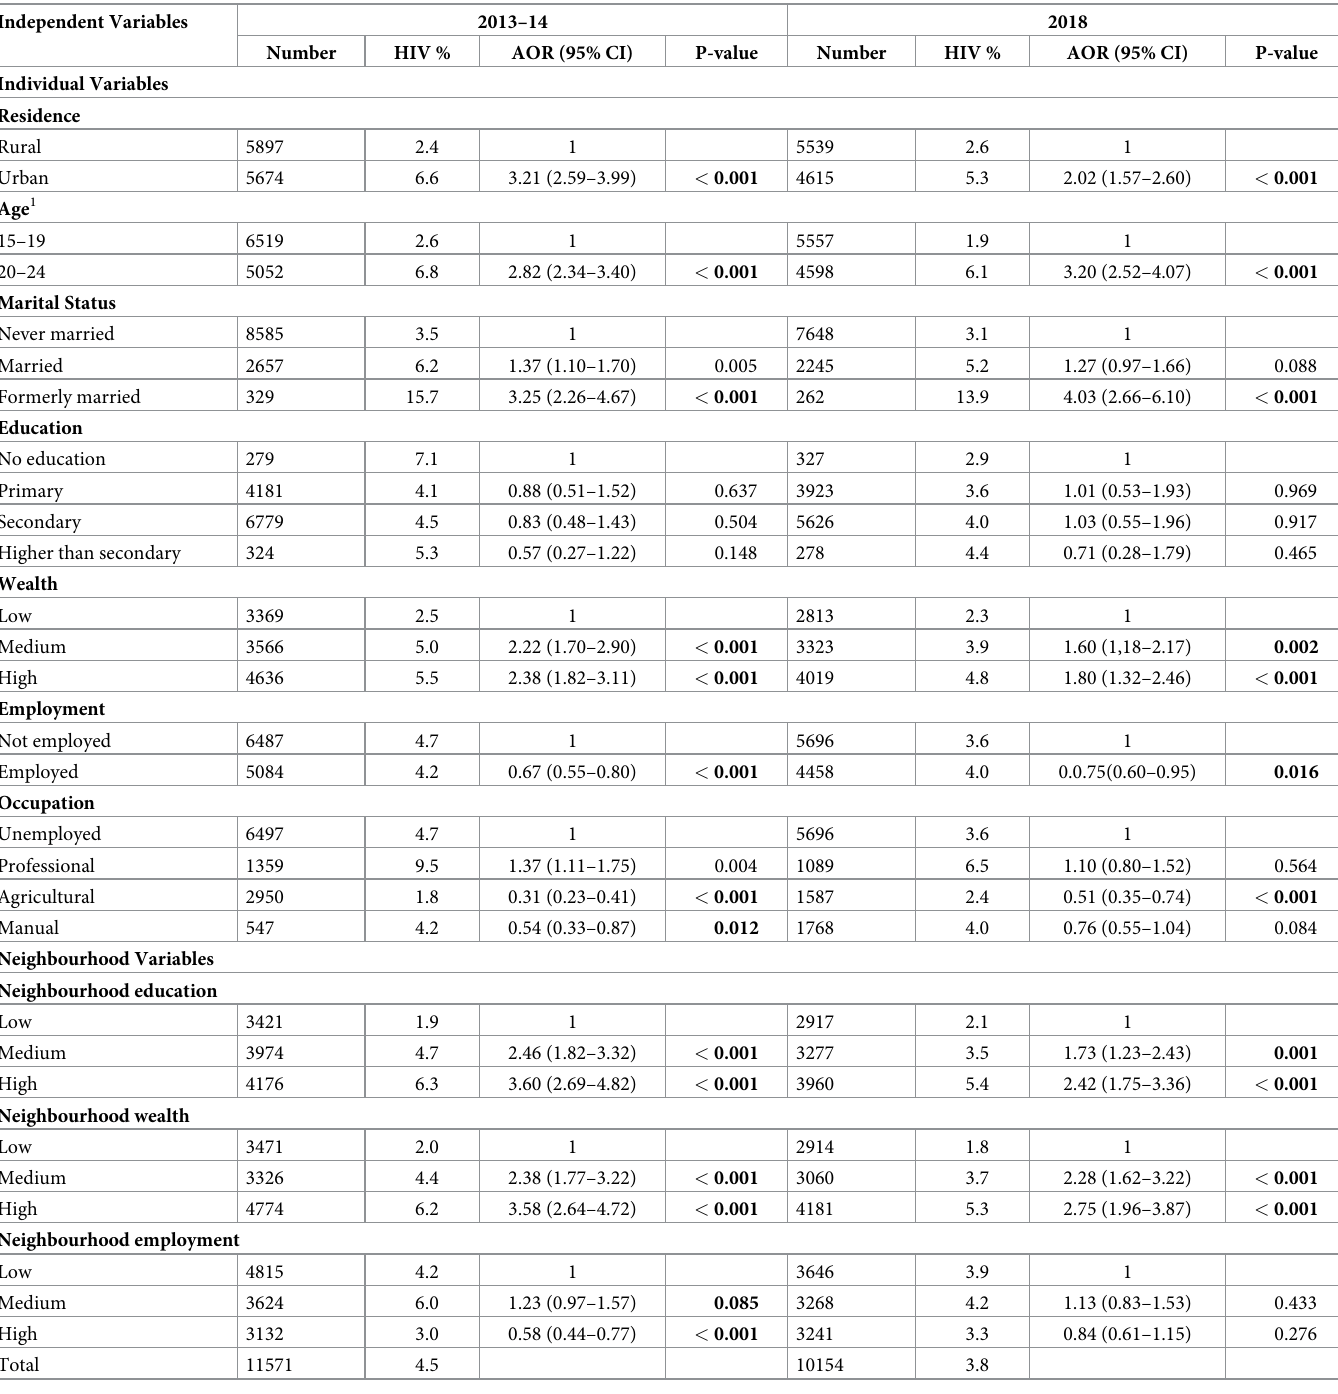
Table 1. HIV prevalence and age-adjusted odds ratios by background characteristics among young people 15–24 years, 2013–14 and 2018,